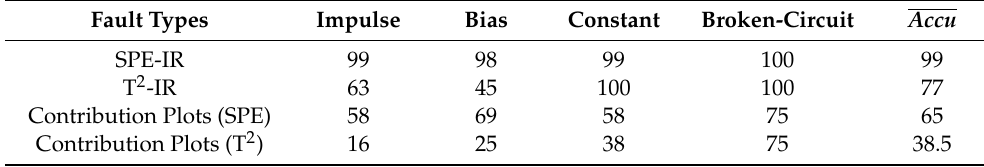
Table 7. Isolation Accuracy of Different Fault Isolation